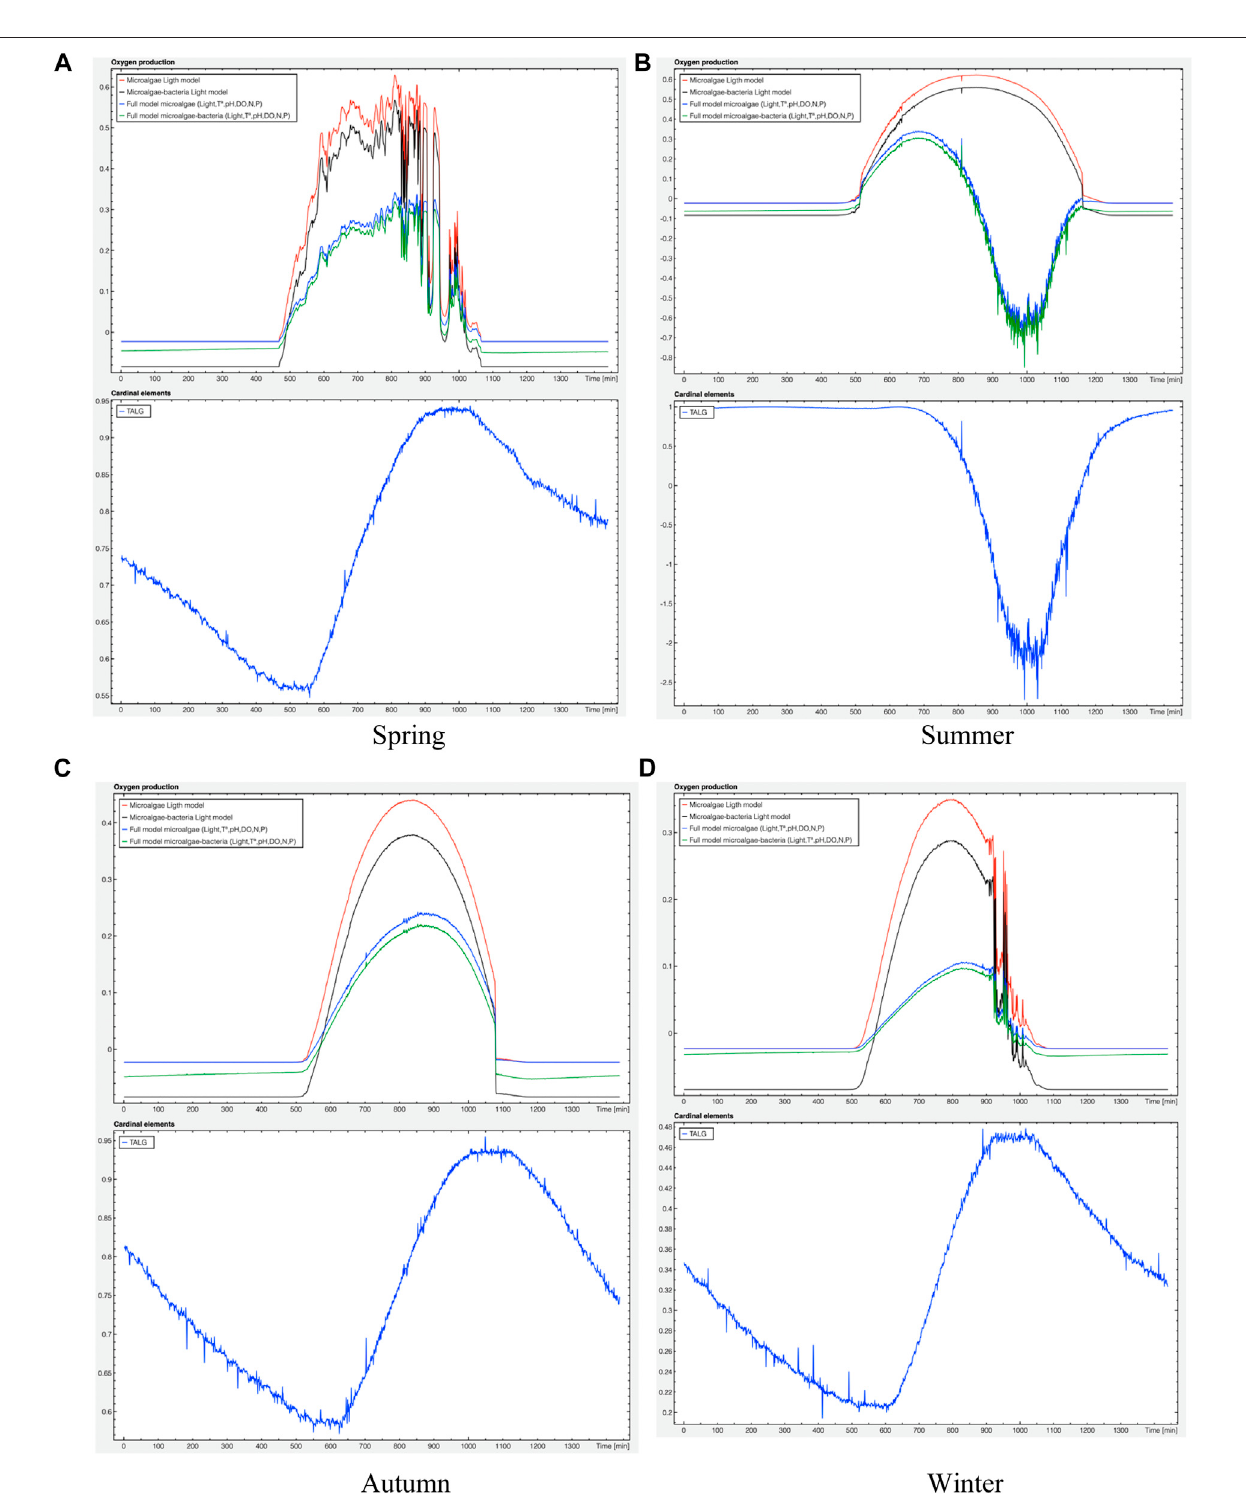
FIGURE 9 | Oxygen production by Nannochloropsis oceanica during the seasons of the year using the proposed biological models, along with the temperature effect using its temperature speci fi c parameters: spring (Panel 9A ) summer (Panel 9B ), autunm (Panel 9C ), winter (Panel 9D ).